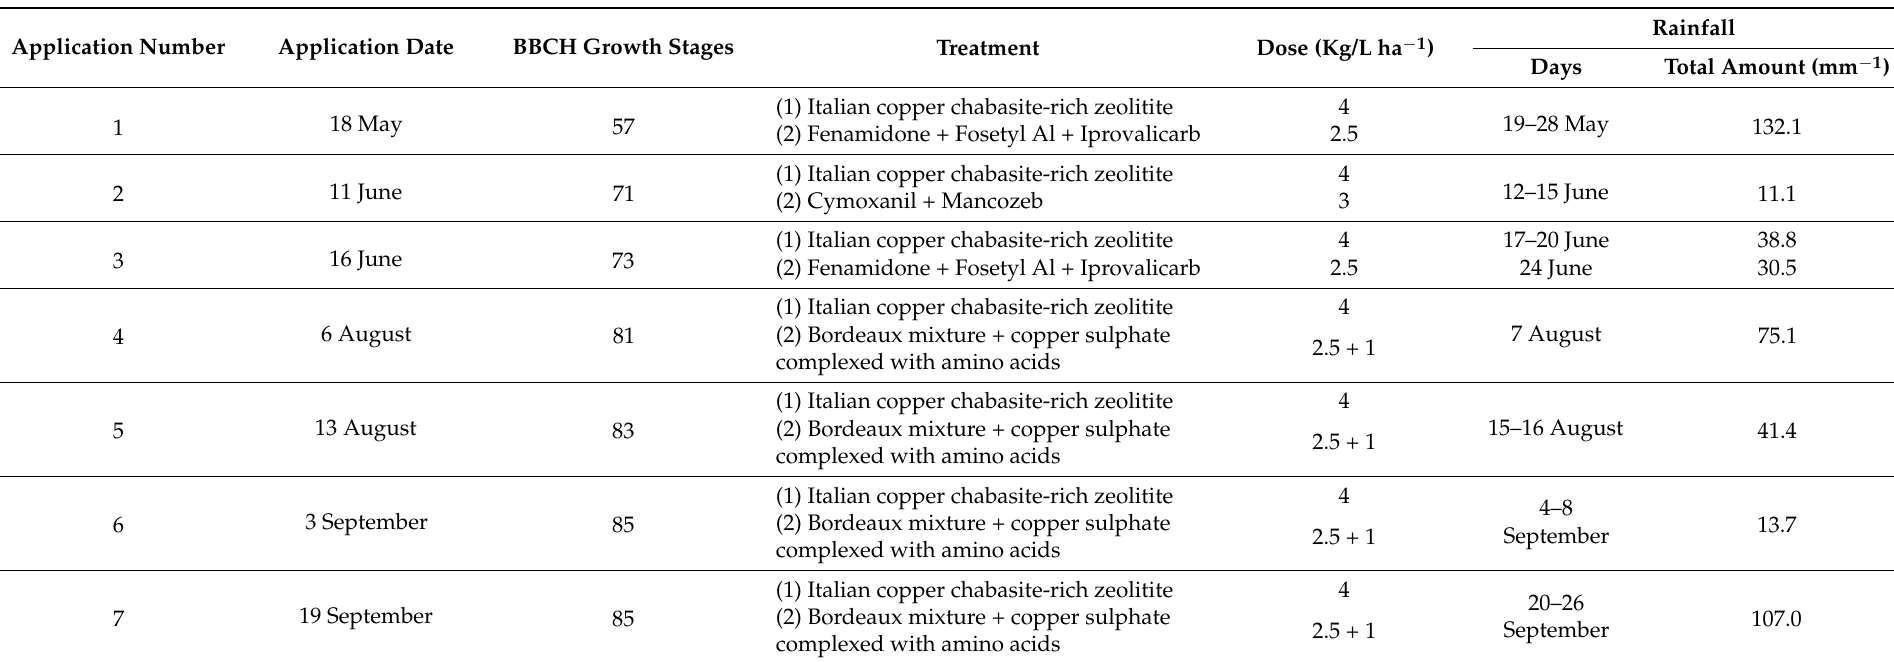
Table 1. Field application details targeted against grapevine downy mildew in cv. Montepulciano in the Ari vineyard in 2015 and rainfall amount on the days after the